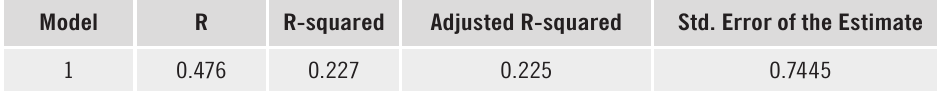
Table 12. Summary of the regression model: the level of market orientation and competitiveness